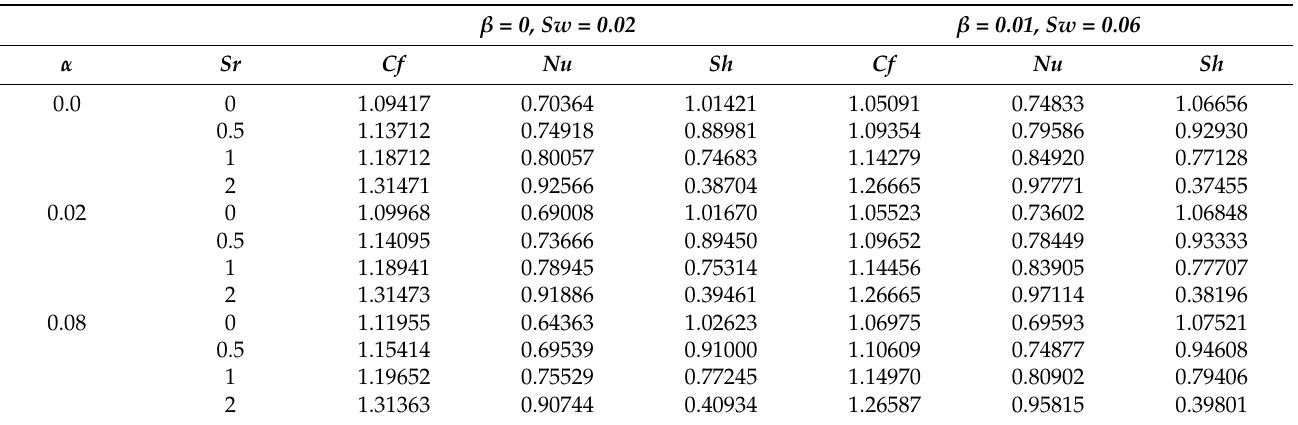
Table 2. Numeric values of local skin friction, local Nusselt, and local Sherwood numbers for distinct values of heat generation parameter ( α ) and Soret number (Sr) when M = 1.0, R = 0.5, Pr = 0.71, E = 0.01, S w = 0.1, Sr = 0.2, Df = 0.3, Sc = 0.61. β = 0, Sw =